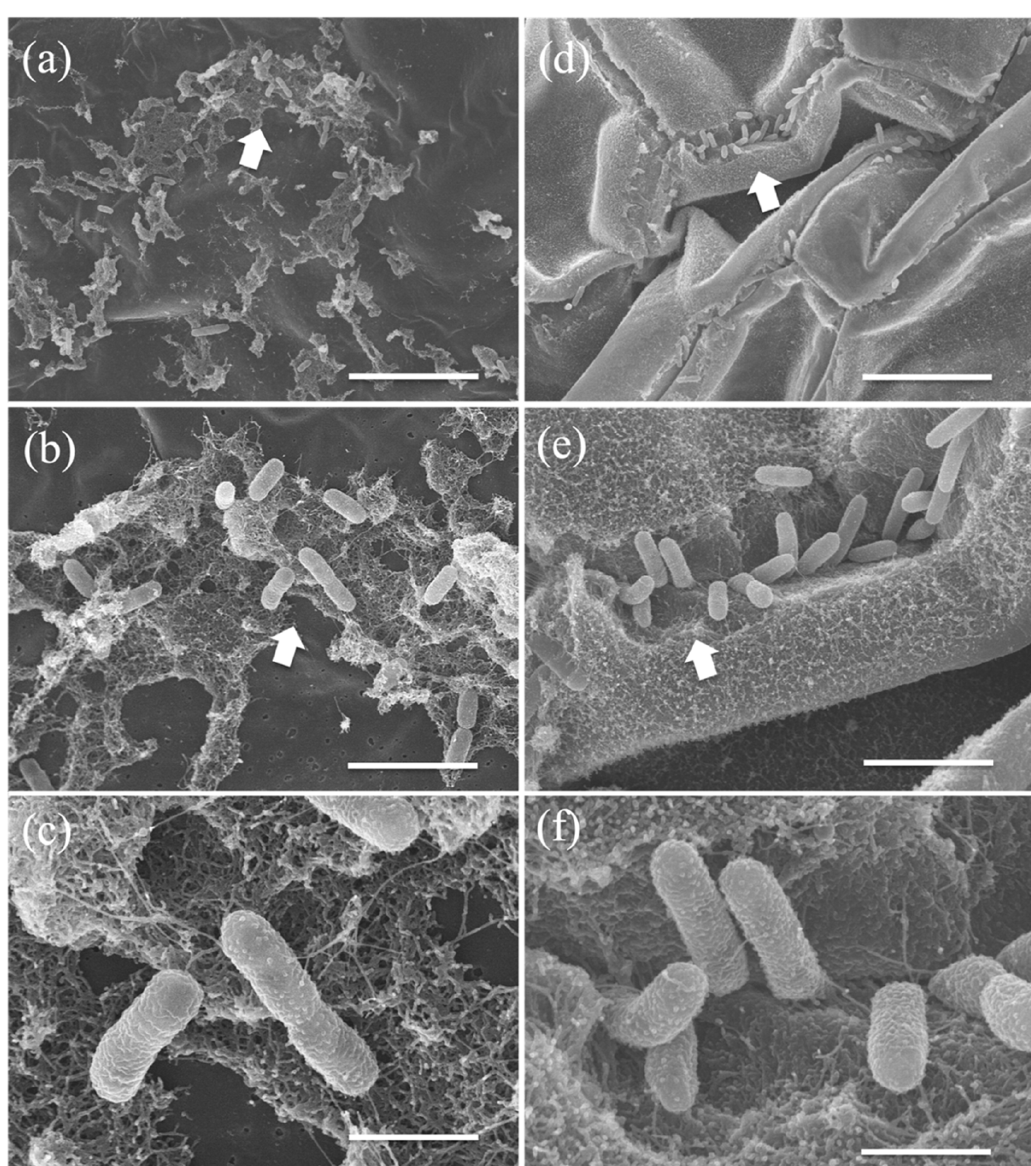
Figure 5. Scanning electron micrographs of bacterial cells attached on the frond and root surface of Lemna minor co-cultured with MRB3. Cells (rod shape) of strain MRB3 adhered to and colonized (close-ups of arrows from ( a – c )) the frond ventral side and (close-ups from ( d – f )) the root surface at day 7. Scale bars: ( a ) and ( d ), 10 µm; ( b ) and ( e ), 3 µm; ( c ) and ( f ), 1 µm.